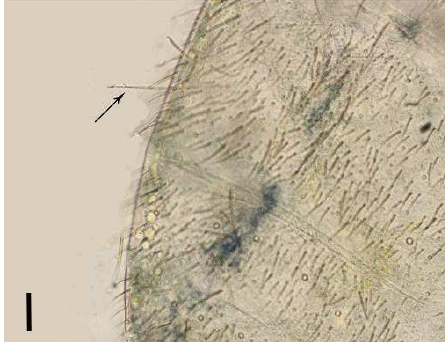
F IGURE 19. Trichobothria on abdomen 5 of Isotomurus (scale: 25 µm) . Folsomides parvulus Stach,